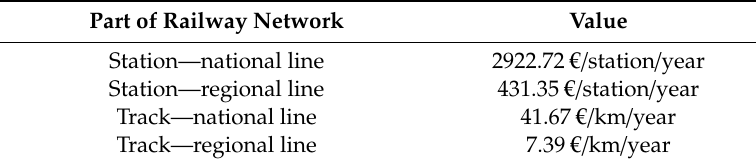
Table 7. Values of the overall socioeconomic impacts of